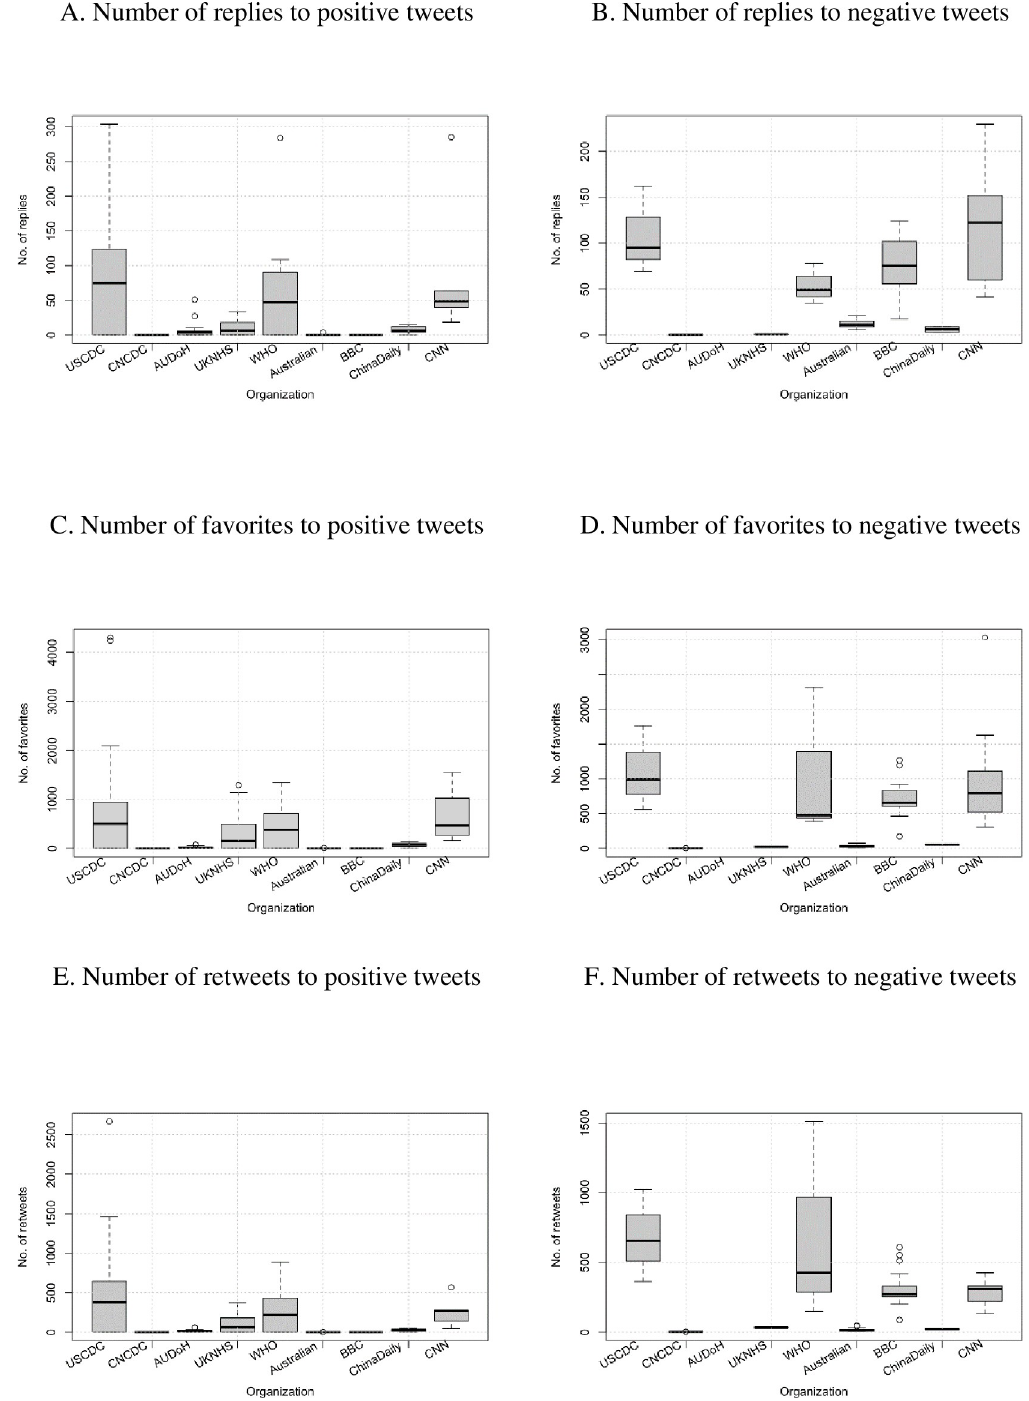
Fig 4. Number of responses (replies, favorites, retweets) to positive and negative tweets from the five government organizations and four news agencies.